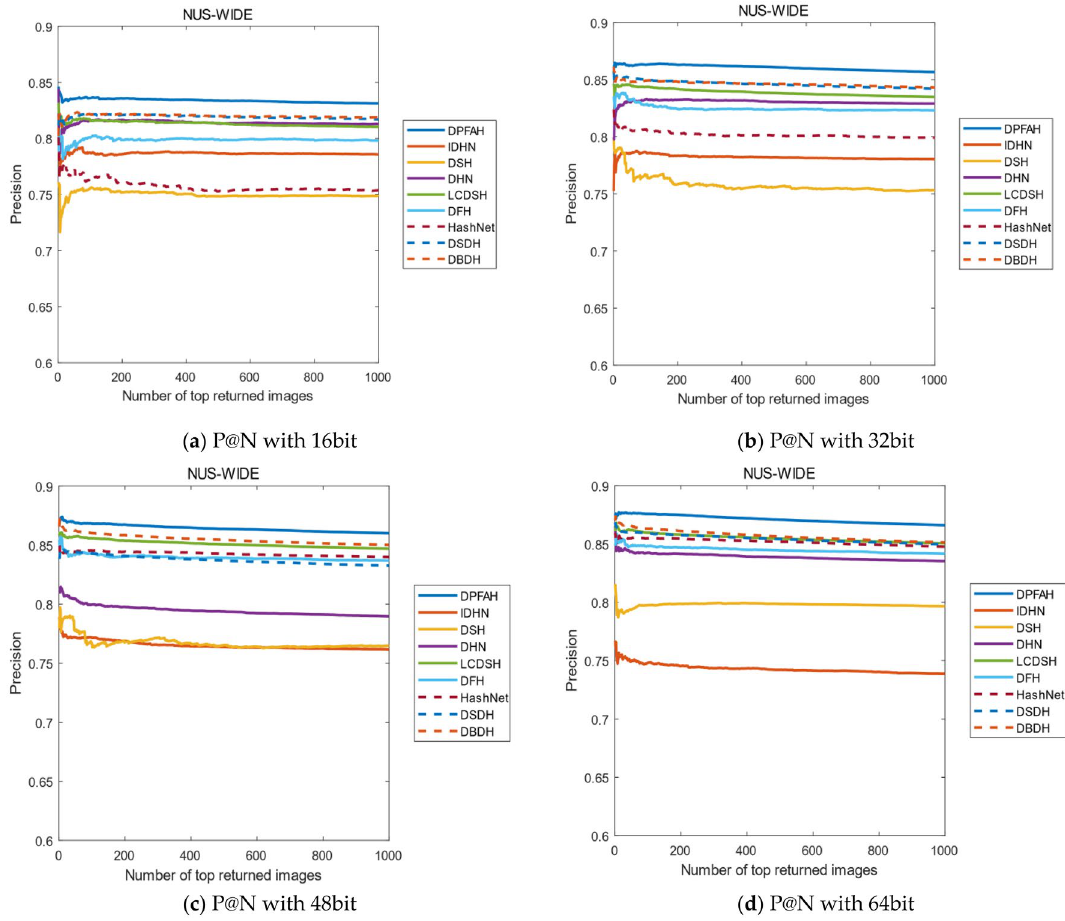
Figure 13. ( a–d ) Represent the P@N curves on NUS-WIDE of all methods with different bits. (Created by “matlab R2019a” url: https:// ww2. mathw orks. cn/ produ cts/ matlab.